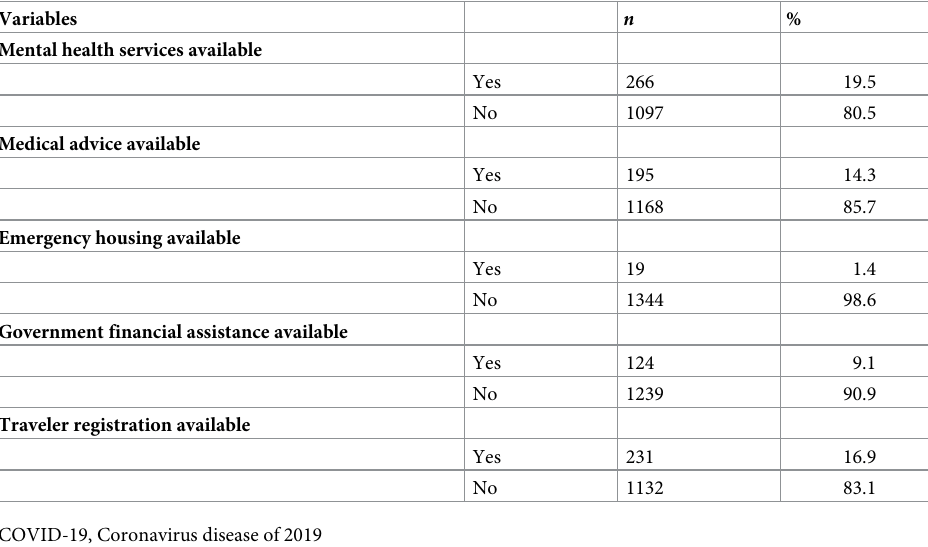
Table 4. Government services available to participants during